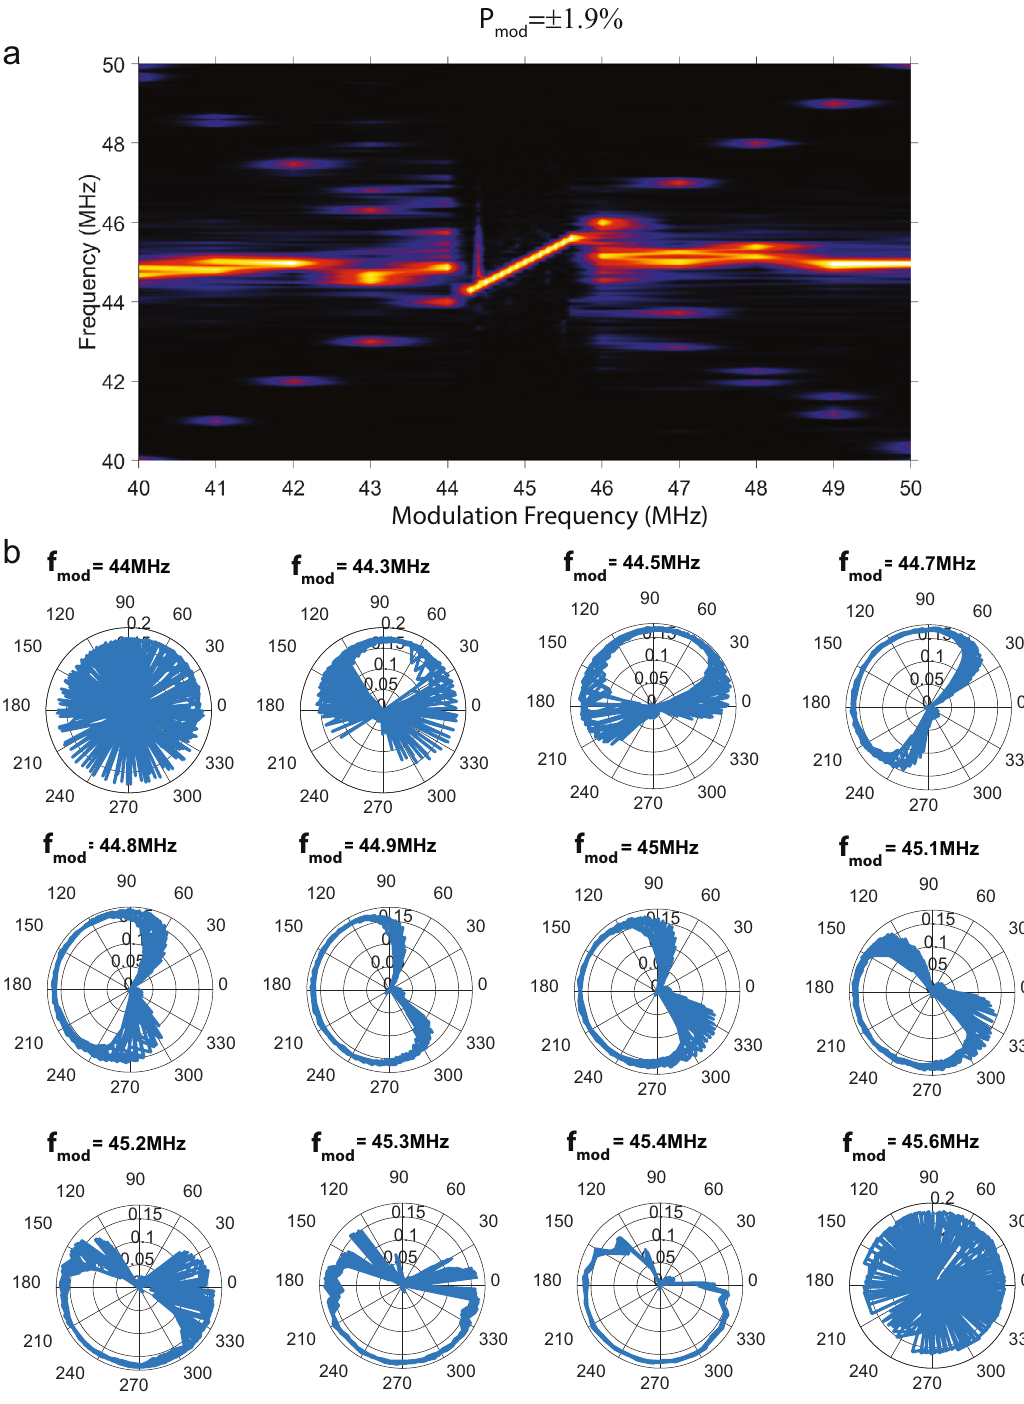
Fig. 5 Arnold tongue for a modulation amplitudes of P mod = ±1.9%. a Colormap of the power spectral density (PSD). b Time traces of the transmission signal in a polar representation, where the distance to the center is the transmission value and the angle is the phase difference with respect to the maximum of the modulation signal. Each panel corresponds to a different modulation frequency, covering the spectral width of the Arnold